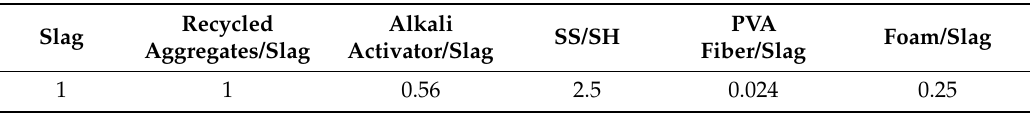
Table 2. The mix proportion of alkali-activated foam concrete (based on mass ratios).